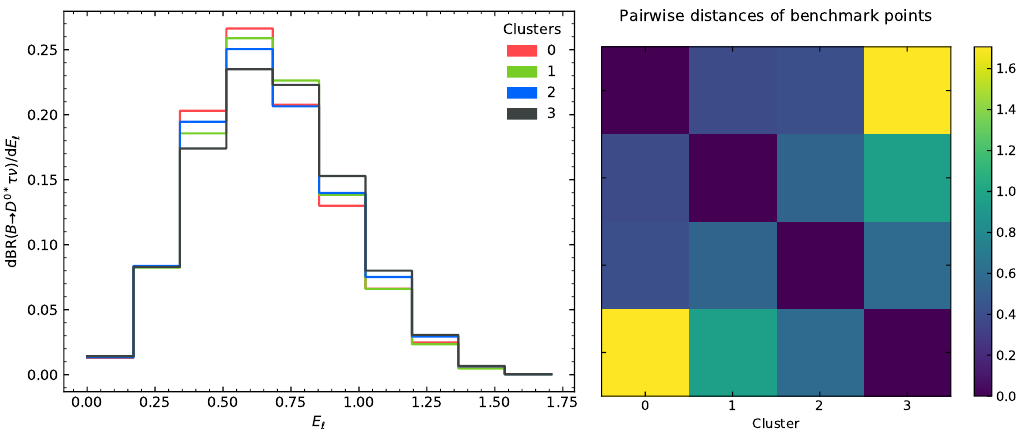
Figure 7 . Benchmark E ‘ -distributions of the decay width (cid:0)( (cid:22) B ! D(cid:28) (cid:0) ( ! ‘ (cid:22) (cid:23) ‘ (cid:23) (cid:28) )(cid:22) (cid:23) (cid:28) ) for a yield of 2000 events and a relative uncertainty of 1%. The matrix plot shows the pairwise distances between the kinematic